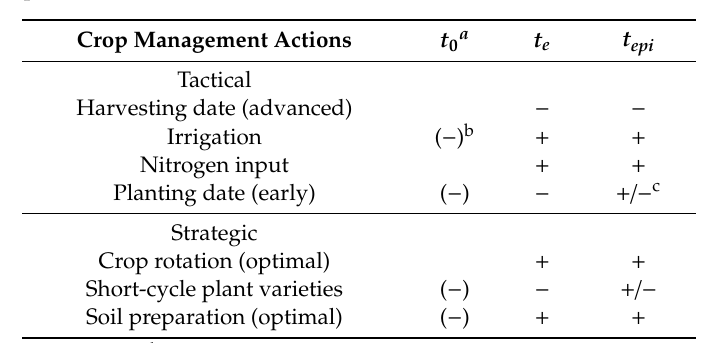
Table 4. Main e ff ects of crop management actions on advancing ( + ) or delaying ( − ) times that a ff ect the duration of the epidemic.